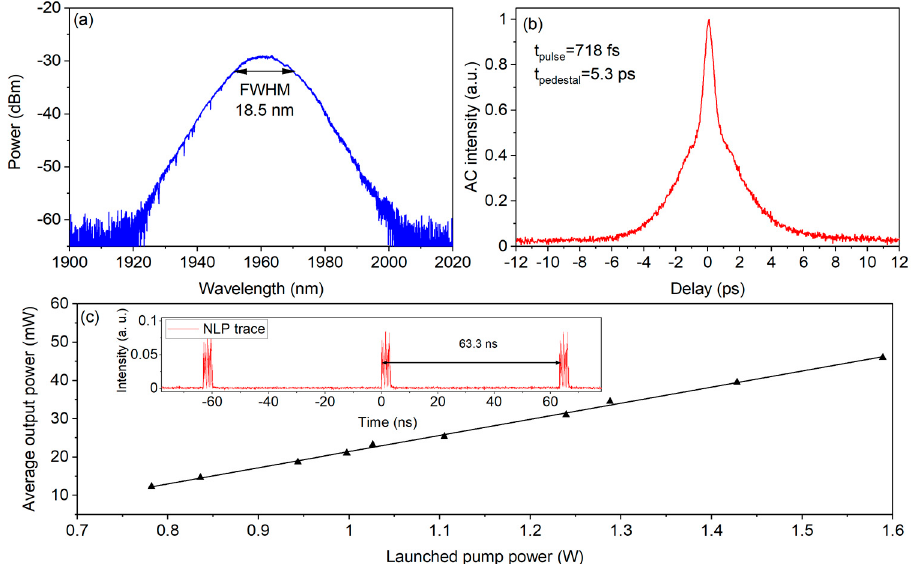
Figure 4. Noise-like pulse generation characteristics: ( a ) optical spectrum and ( b ) autocorrelation trace for 46 mW of average output power; ( c ) average output power as a function of the pump power launched into the TDF; the inset shows the oscilloscope trace of the NLP train.